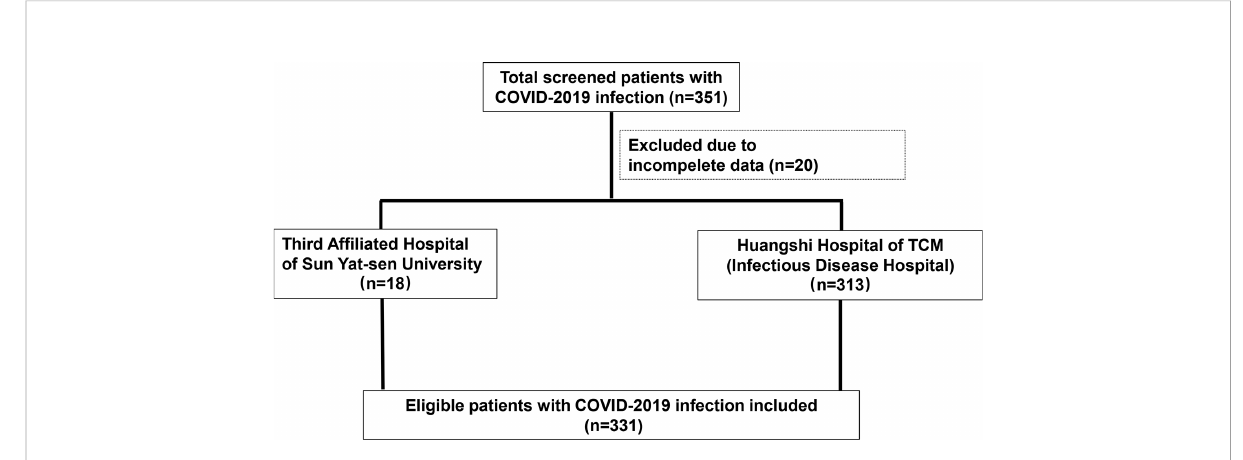
FIGURE 1 Flow chart of enrolled patients with